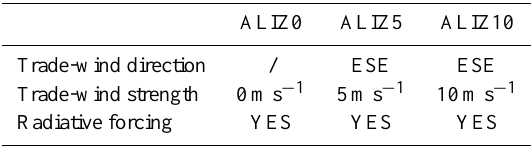
Table 2. Main characteristics of the numerical